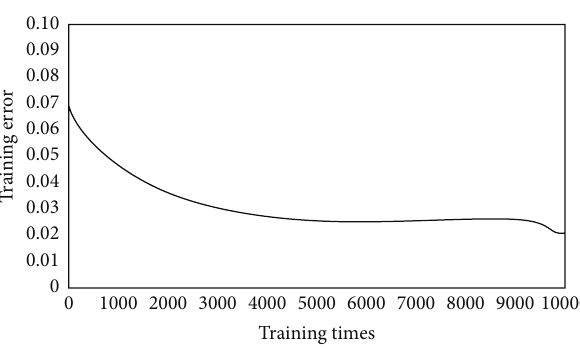
Figure 6: Improved BP algorithm fitting curve.